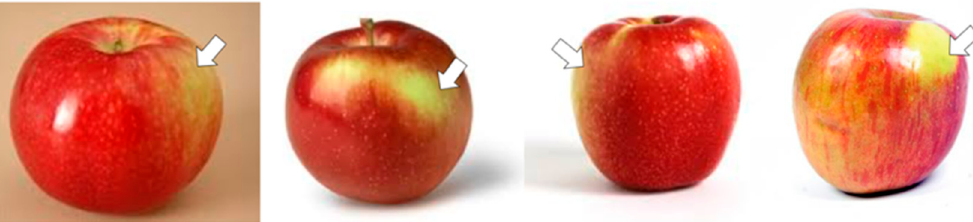
Figure 6. Examples some of the detection failures on bright-skinned apples with yellow-white flecks images indicated by the arrows.